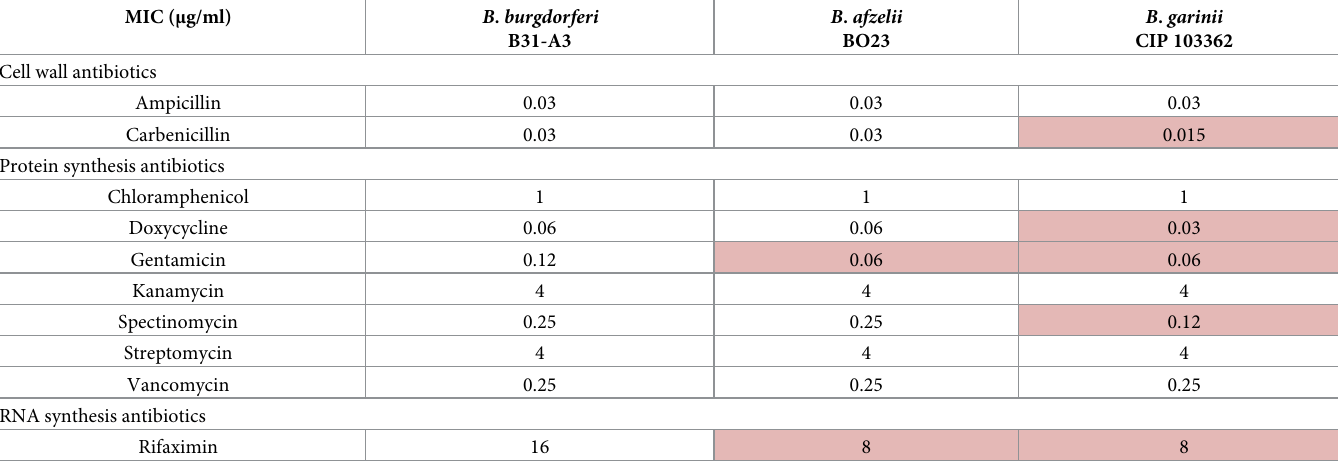
Highlighted in red: the difference in antibiotic susceptibility compared to B . burgdorferi